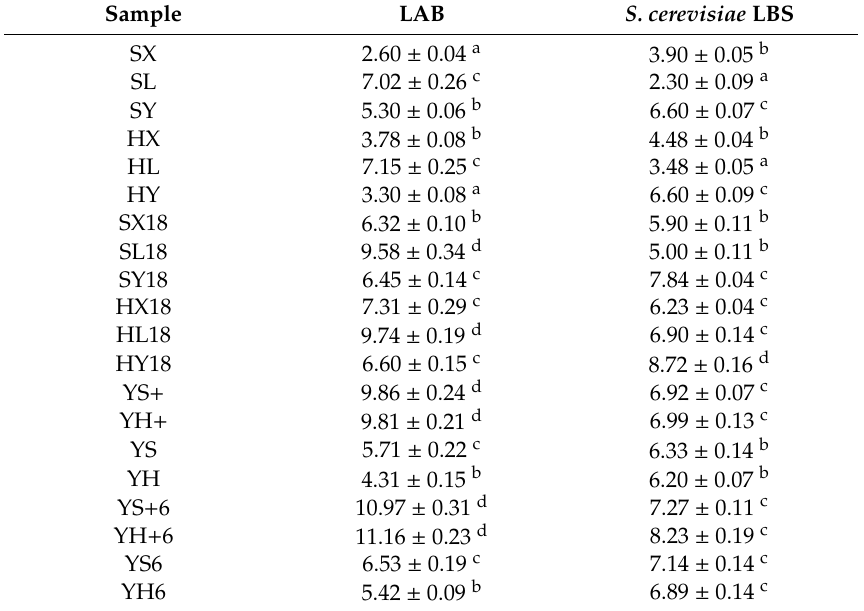
Table 2. Mean values of lactic acid bacteria (LAB) and yeast growth (Log 10 cells /